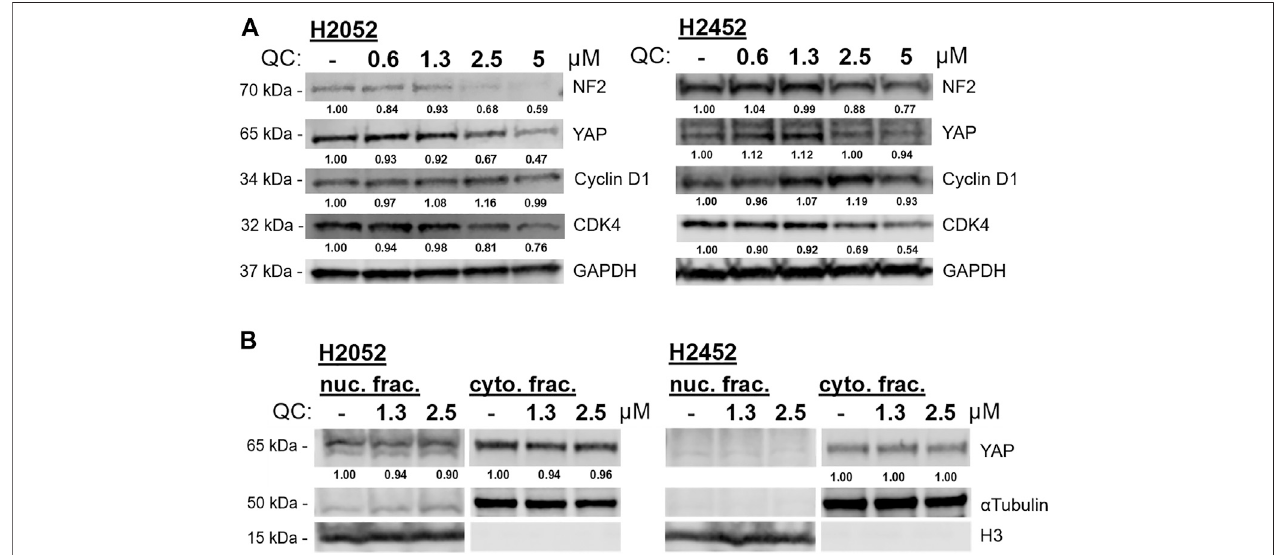
FIGURE 5 | (A) Quinacrine (QC)-induced protein changes to biomarkers of the hippo signaling pathway at incrementing concentrations. (B) Nuclear and cytoplasmic fractions for YAP detection with quinacrine treatment. Densitometry values are normalized to respective loading control (GAPDH, α tubulin, or